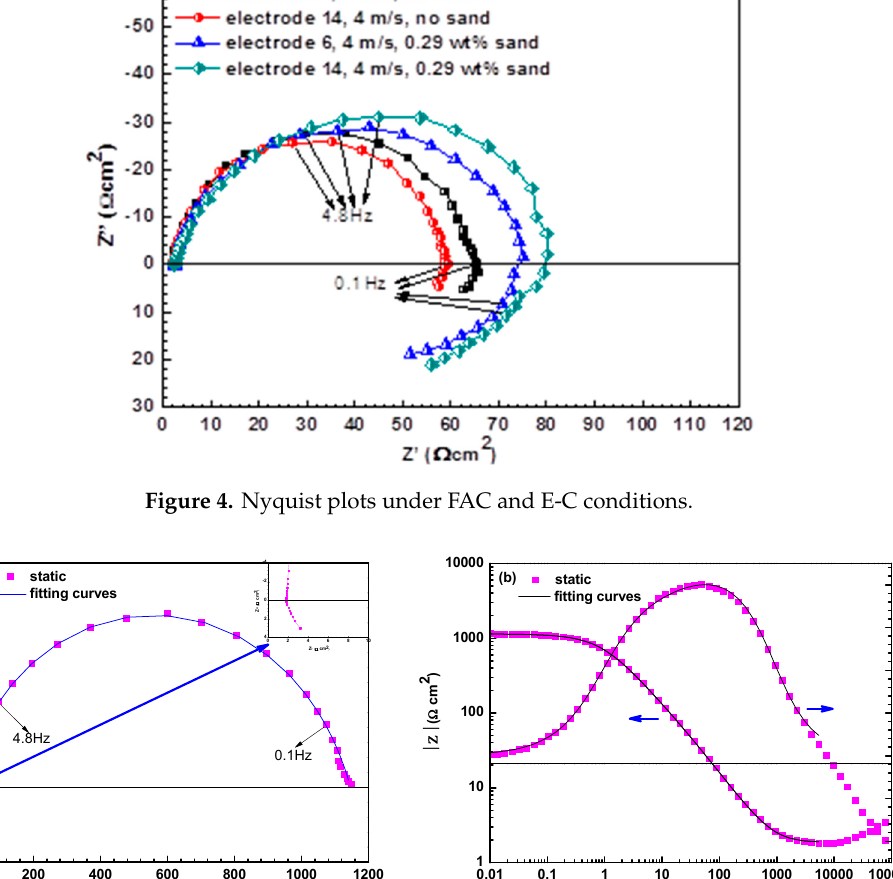
Figure 5. Nyquist ( a ) and Bode ( b ) plots of electrodes under the static state.